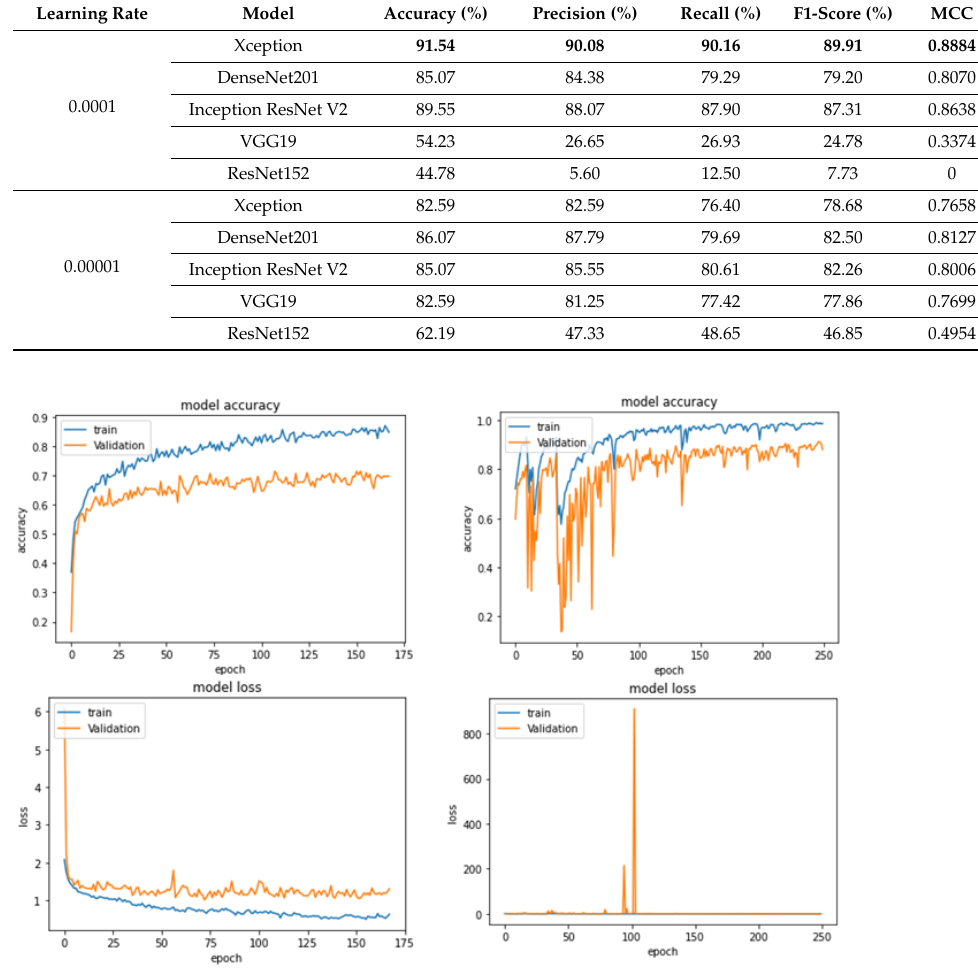
Table 12. Results of 200 × magnification factor in multi-classification mode; the highest results are shown in bold.